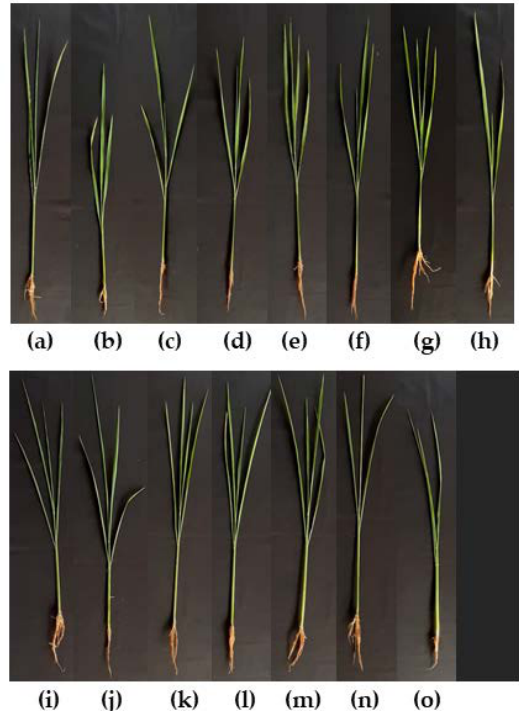
Figure 6. Rice seedlings (45-day-old) obtained from ( a ) seed treated with sterile water (negative control); ( b ) seed inoculated with H. oryzae DOAC 2293 alone (positive control); and seed inoculated with H. oryzae DOAC 2293 ( c ) with C. michaelii YE-239; ( d ) with H. sinensis YE-19; ( e ) with H. sinensis YE-58; ( f ) with M. caribica DMKU-RP55; ( g ) with P. hubiensis YE-21; ( h ) with K. ohmeri DMKU-RP57; ( i ) with R. mucilaginosa YE-171; ( j ) with T. indica DMKU-RP31; ( k ) with P. japonica YE-135; ( l ) with W. anomalus DMKU-RP04; ( m ) with W. anomalus YE-42; ( n ) with carbendazim ® ; or ( o ) with mancozeb ® .